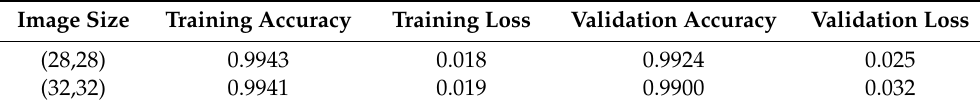
Table 4. Model performances after training Autoencoder 500 epoch.